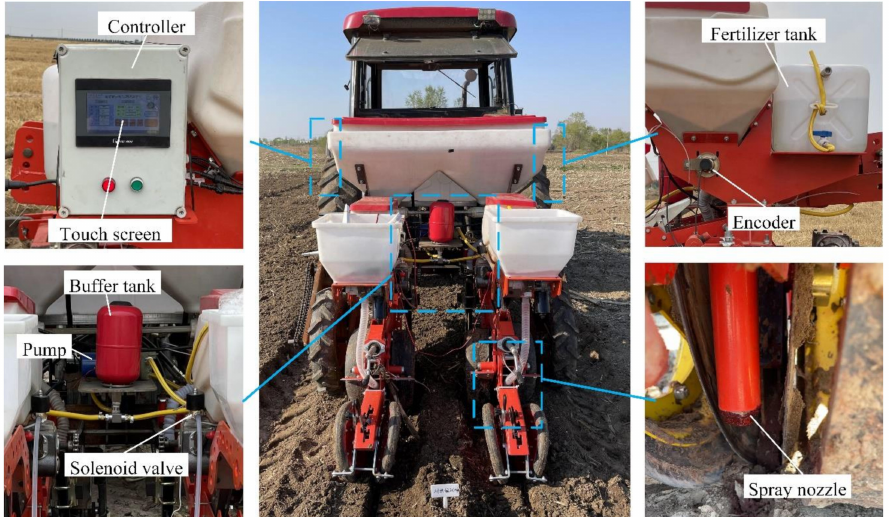
Figure 7. The field experiment with the double-row precise application system for liquid starter fertilizer.